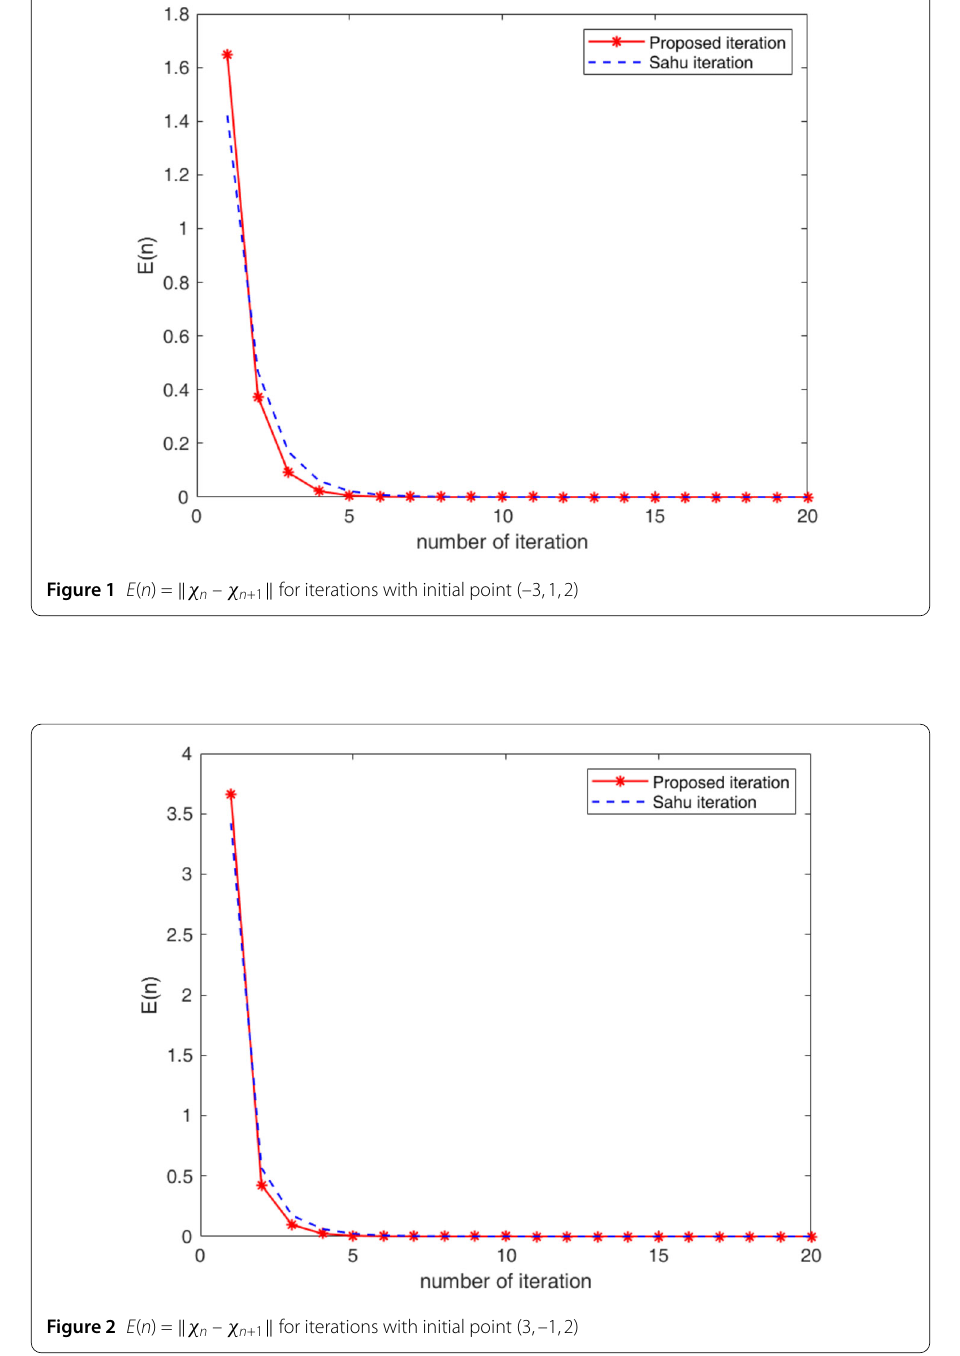
the (cid:2) -convergence of the proposed algorithm. We also provided an application and a numerical result based on our proposed algorithm as well as the computational re- sult by comparing our modified iteration with previously known Sahu’s modified itera-